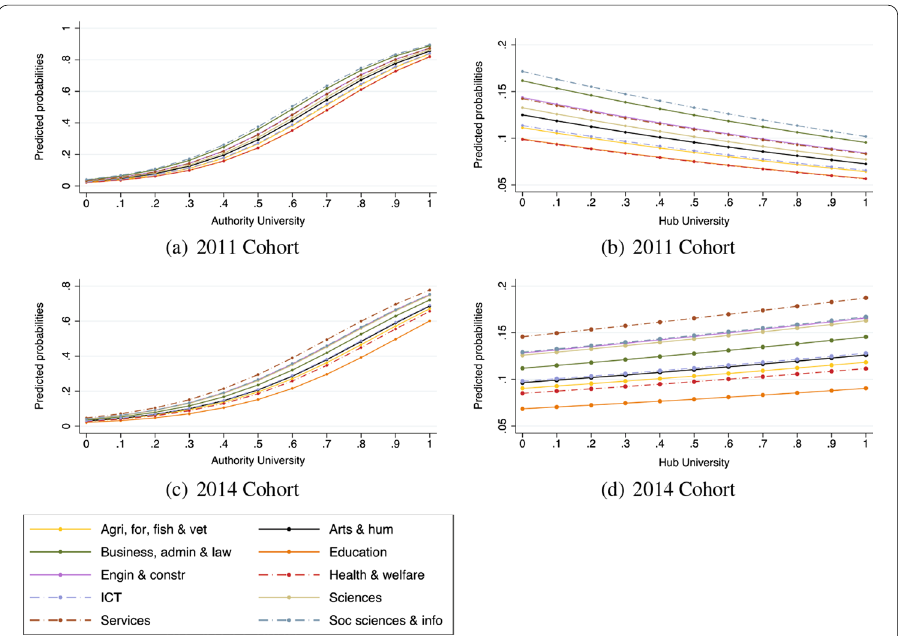
Fig. 5 Marginal predicted probabilities for the 10 disciplinary fields along with authority ( a and c ) and hub ( b and d ) measures. In the calculation of predictions, the remaining variables of the logit model are controlled to their mean